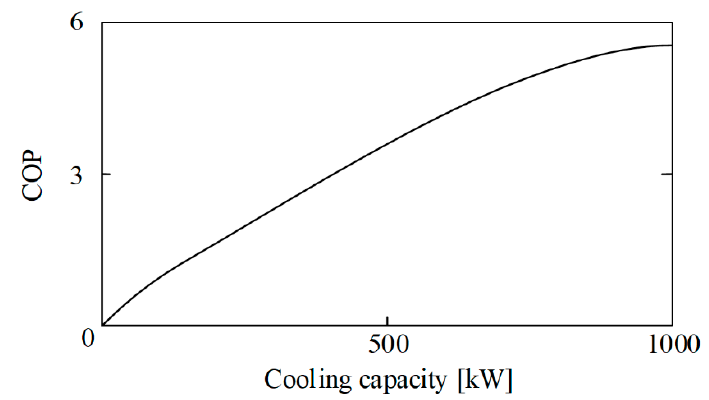
Figure 2. Theoretical cooling capacity–slide valve curve of a screw compressor.